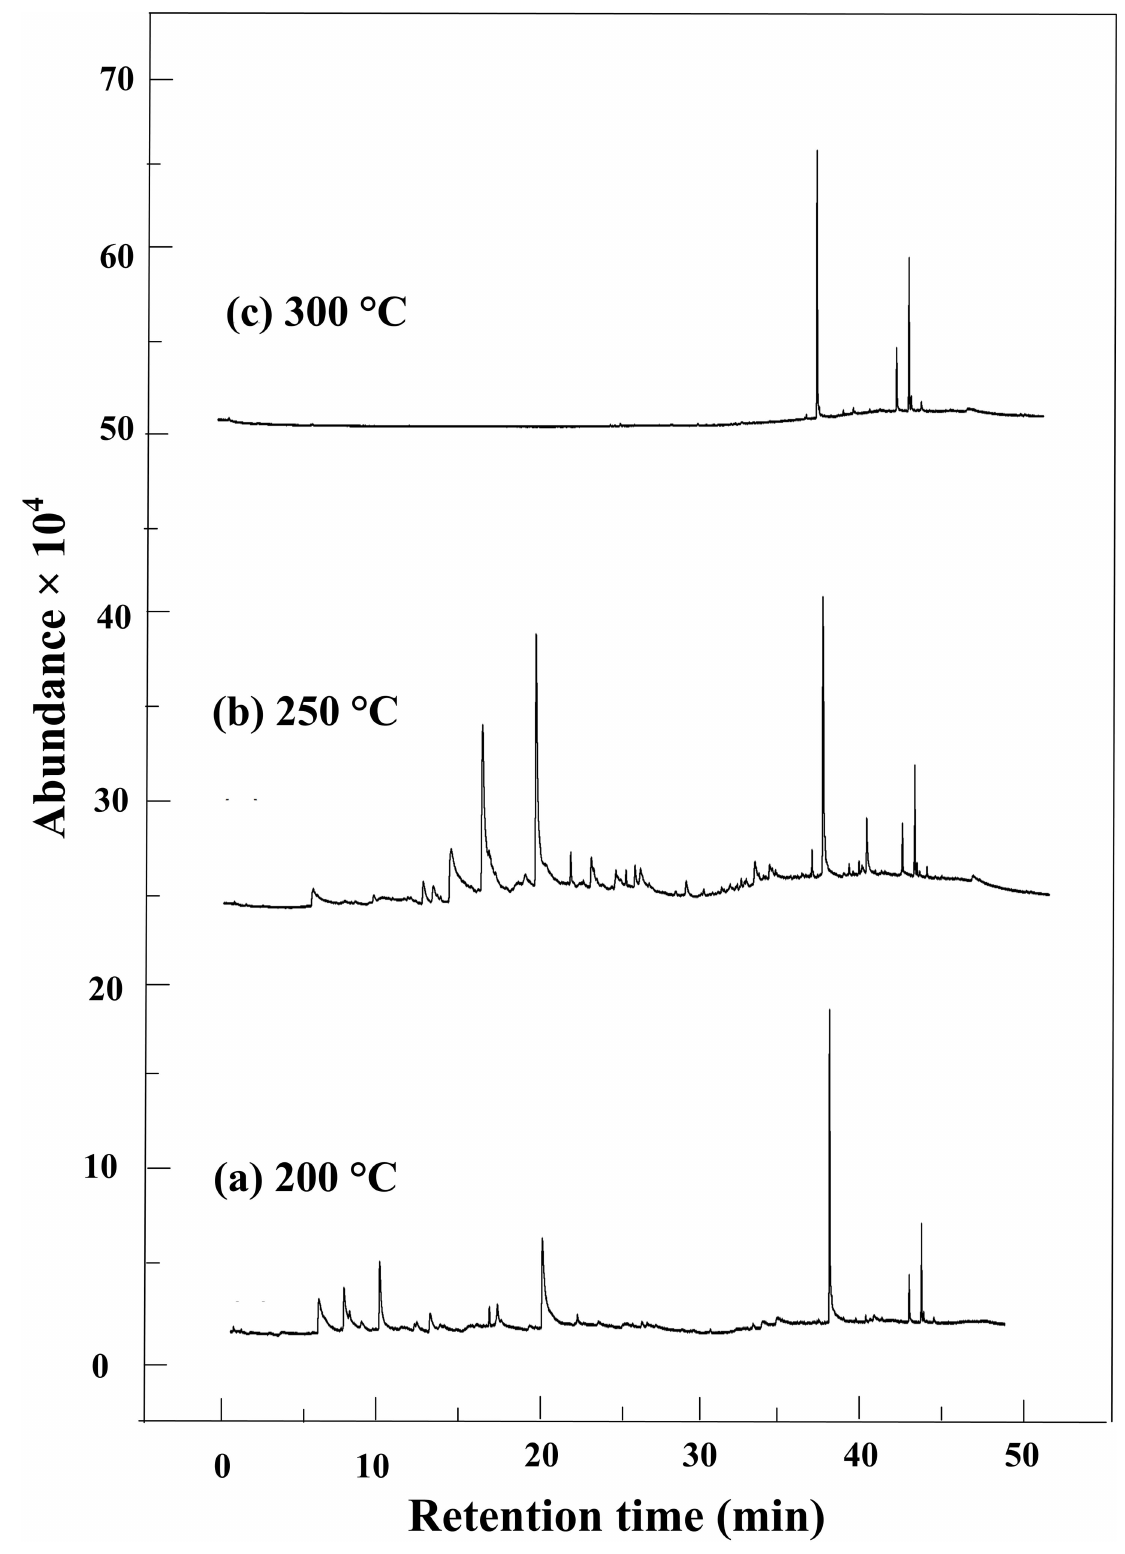
Fig 4. GC-MS spectra of organic byproducts from HTC reactions of bagasse at three temperatures. (a) 200, (b) 250,(c) 300˚C.